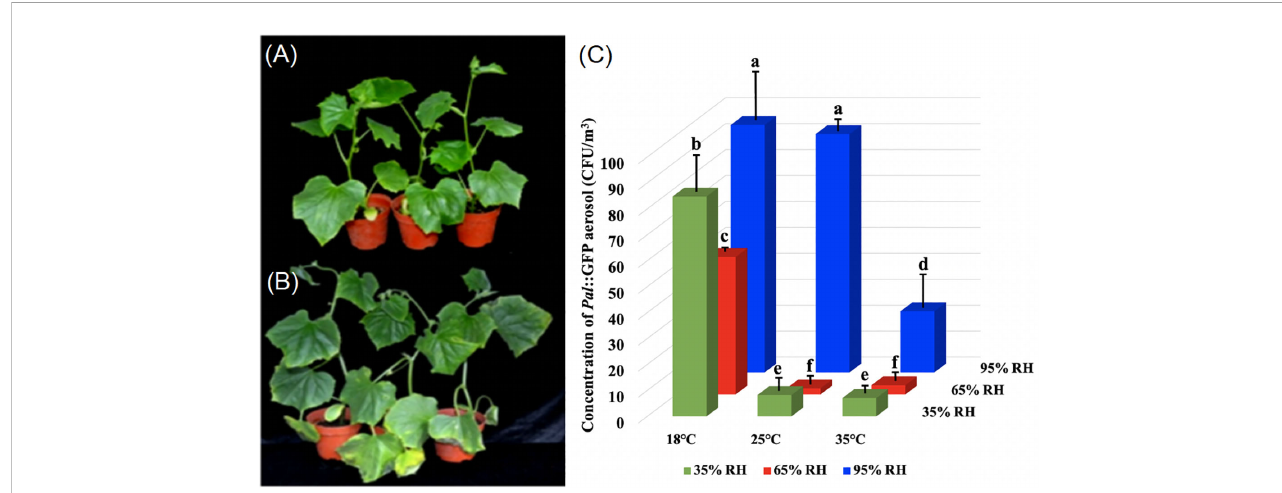
FIGURE 1 Effect of temperature and relative humidity (RH) on the release of Pseudomonas amygdali pv. lachrymans ( Pal ) in aerosols from infected cucumber plants. Twenty cucumber plants at the early stage of the angular leaf spot (ALS) disease, were placed in nine exposure chambers, which maintained at temperatures of 18, 25 and 35°C with humidity levels of 35%, 65% and 95% RH per temperature, respectively. (A) , Cucumber plants inoculated with sterile water. (B) , Symptoms on cucumber plants at the early stage of the ALS disease, which inoculated with Pal ::GFP suspension. (C) , The release amount of Pal ::GFP in aerosols, which detected at 24 h after incubation under different conditions of temperature and RH levels. The experiments were independently repeated three times. Columns and error bars represent the mean values and standard deviations (SDs) from three replicates. Columns labeled with different letters indicate statistically signi fi cant differences ( p <